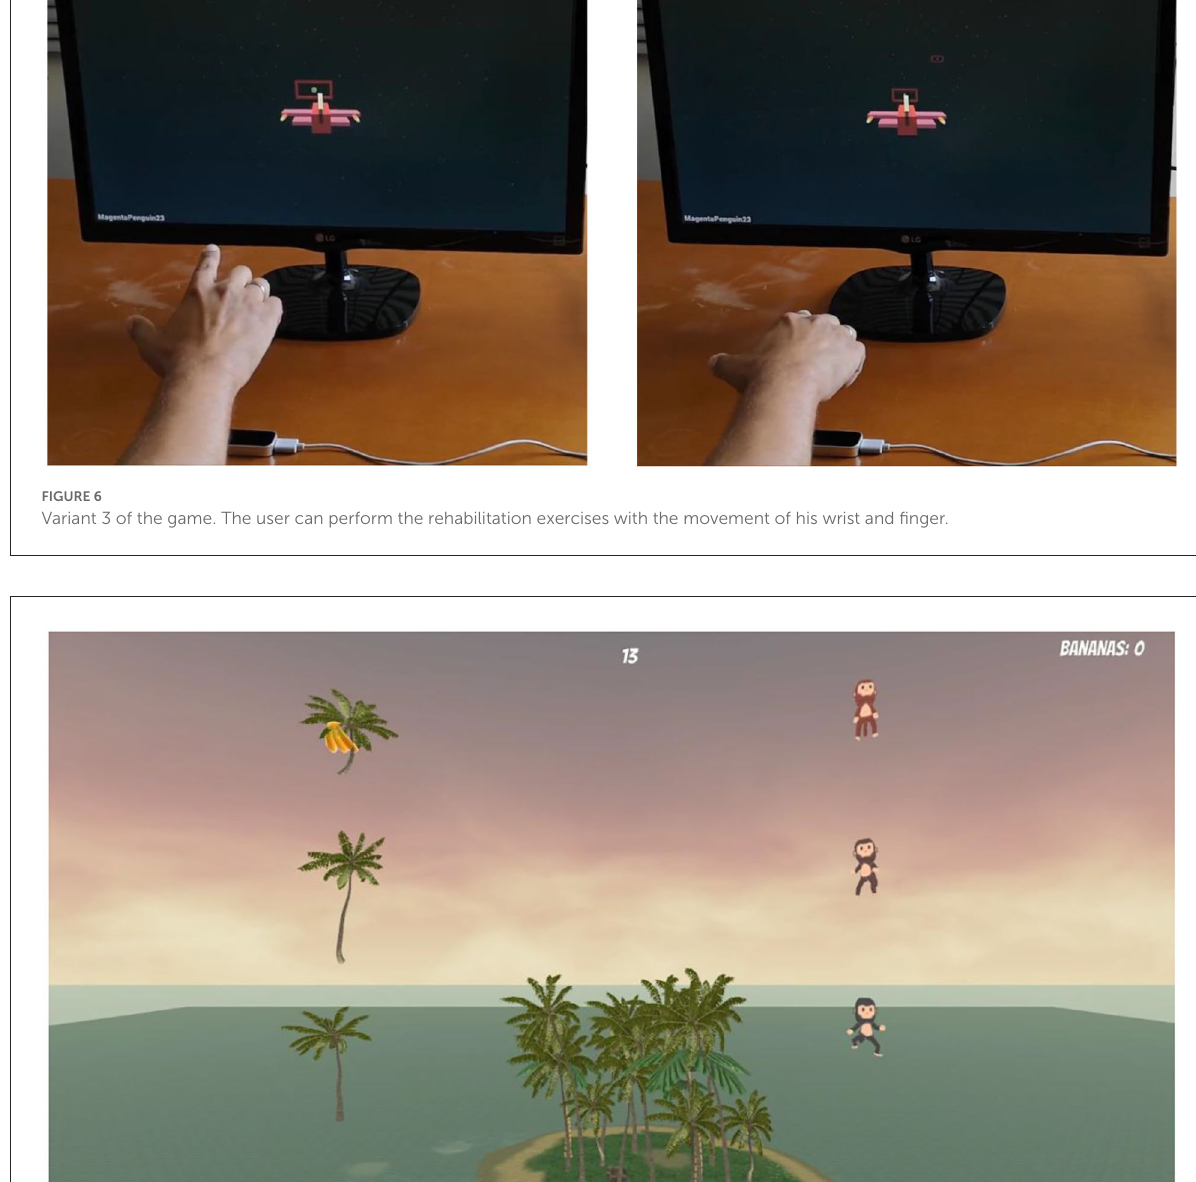
should have specific posture defined by the physician. The game scenario and objectives were explained. After that, the patients were instructed to navigate the airplane from gate to gate with the movement of their hand, trying to pass through